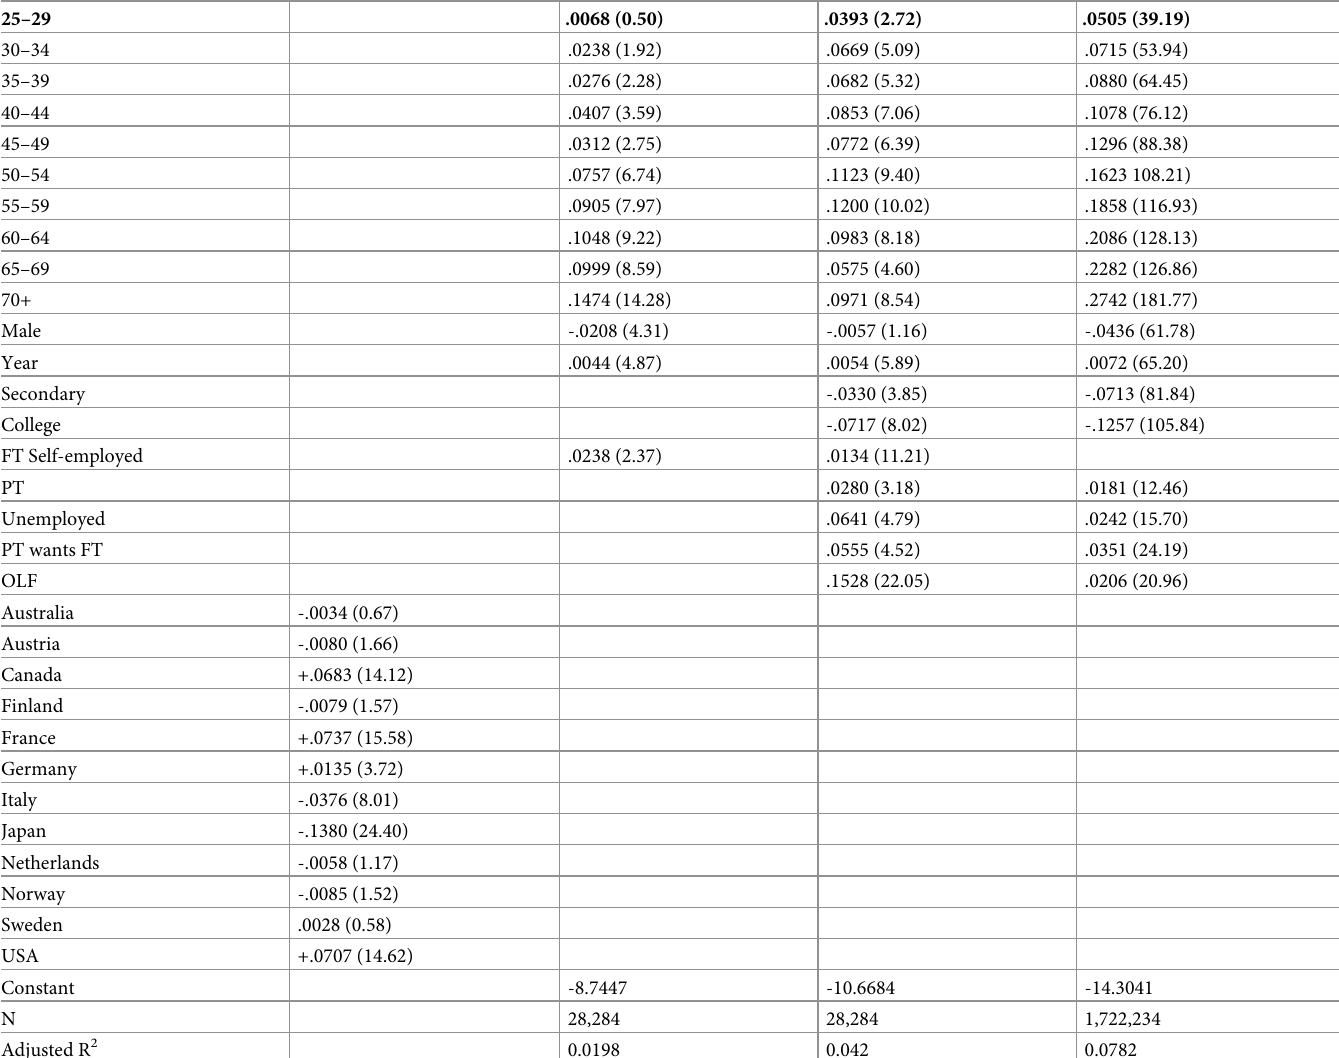
Table 2. Pain regressions in Gallup World Poll, 2009–2020